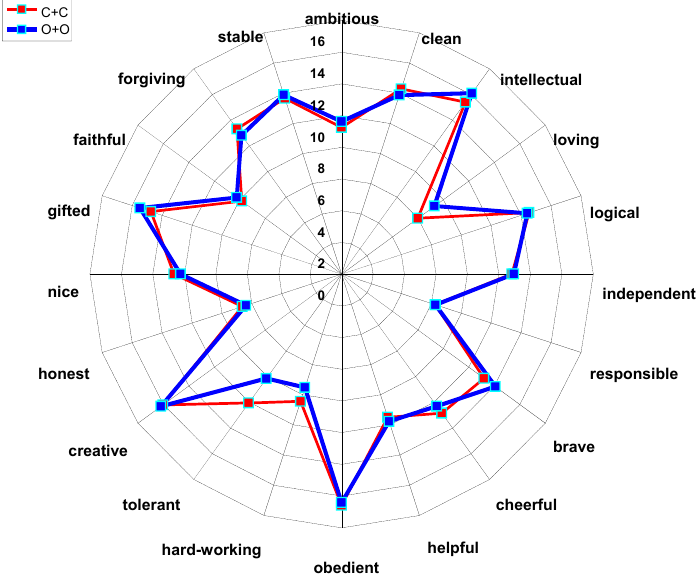
Figure 2. A list of preferences of instrumental values of Catholic and Orthodox respondents representing the same denomination as their family. Source: own study based on research